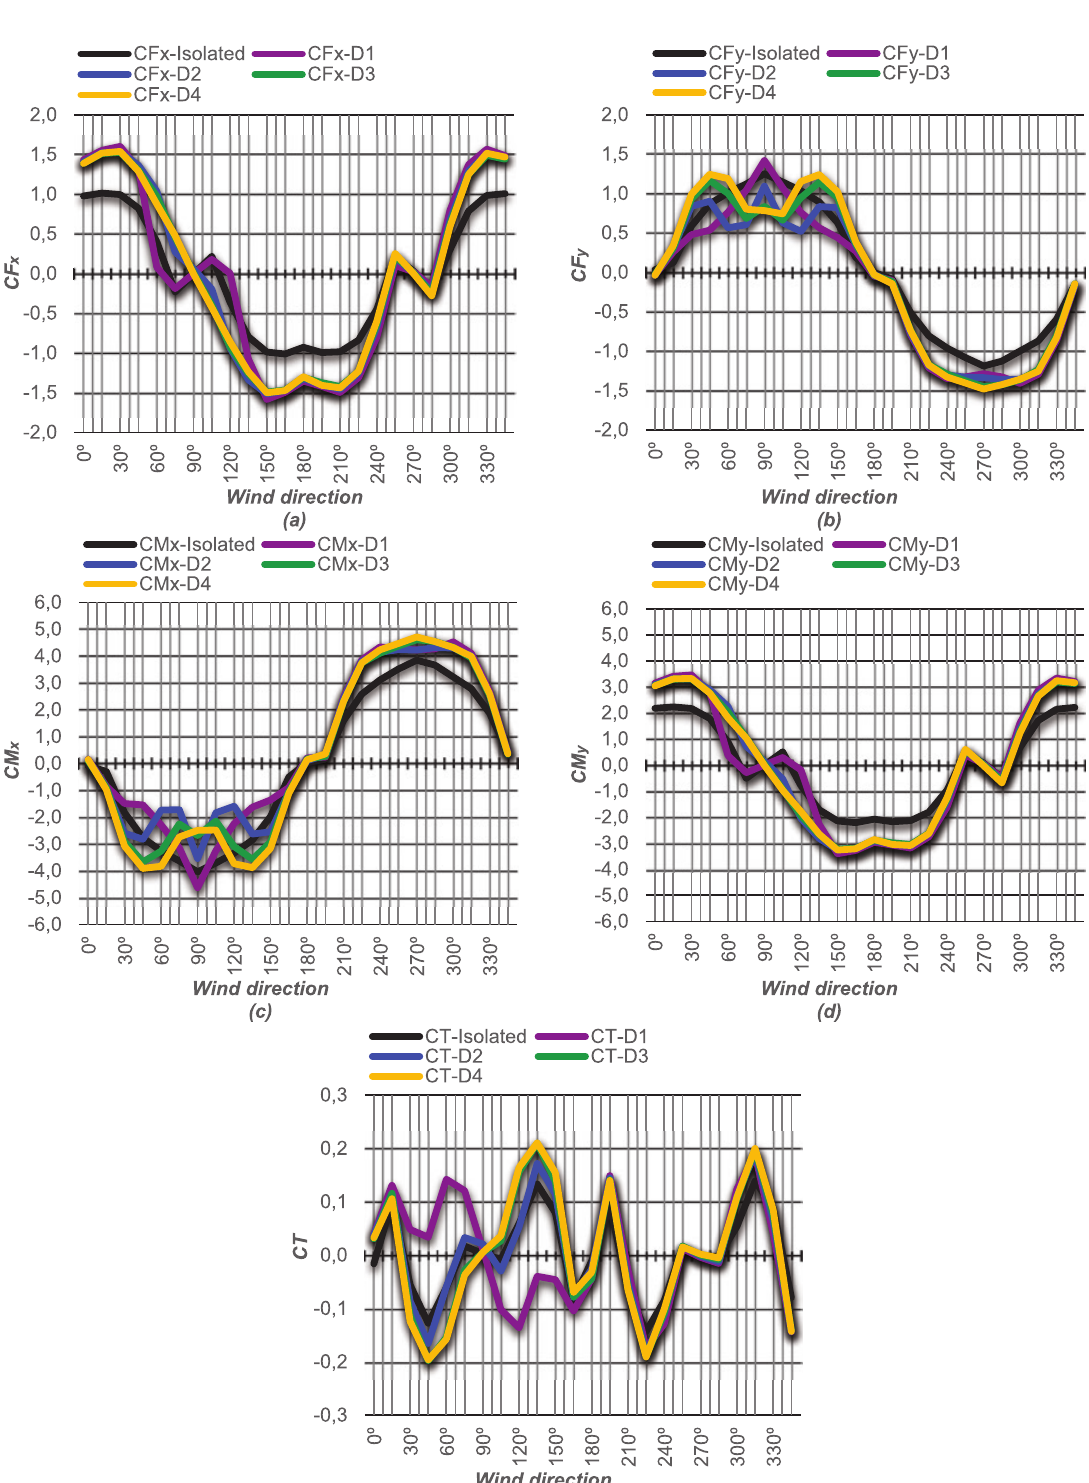
Load coefficients for the vicinity V4: (a) Resultant force in the direction of the X axis; (b) Resultant force in the direction of the Y axis; (c) Base momenta round axis X; (d) Base moment around axis Y; (e) Torsion around building